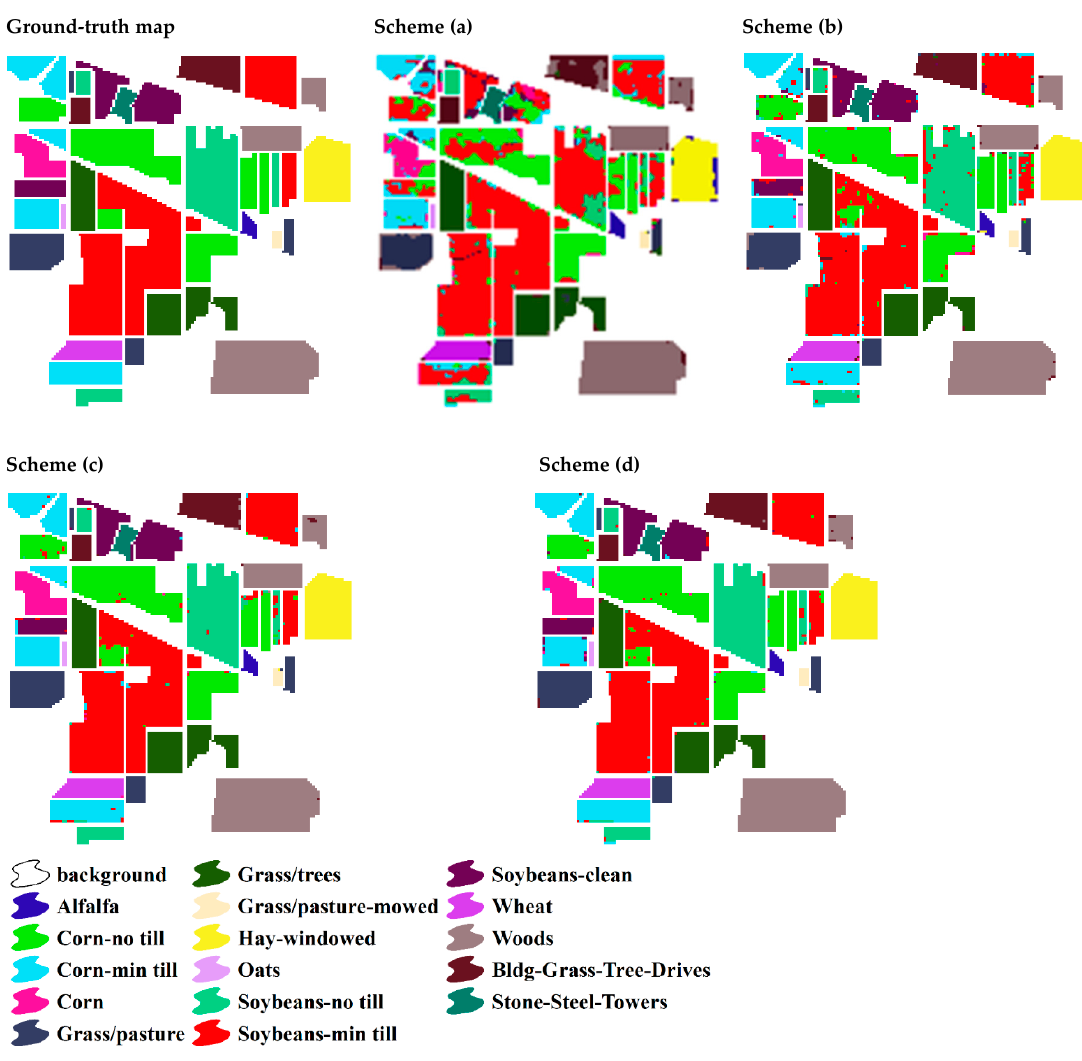
Figure 7. Classification results of the HDCA for the Indian Pines dataset. Scheme ( a ) 1% ( b ) 5%, ( c ) 10%, ( d ) 12.5% of the training samples of each class were used to classify the reference datasets.